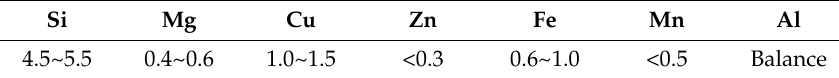
Table 1. Main chemical composition of the AlSi5Cu1Mg alloy (wt